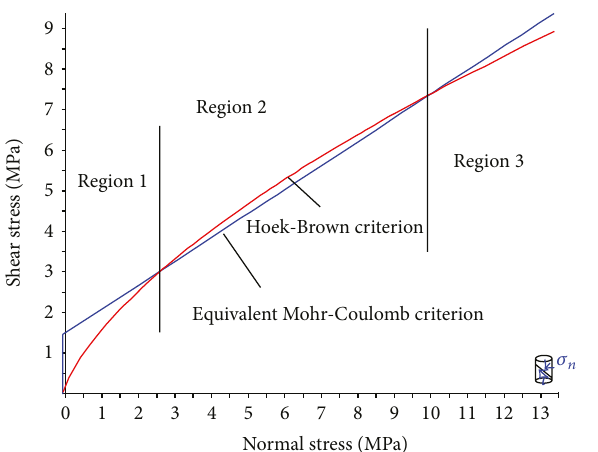
Figure 6: The relation between 𝜎 𝑐𝑖 and the cohesive strength/angle of internal friction.